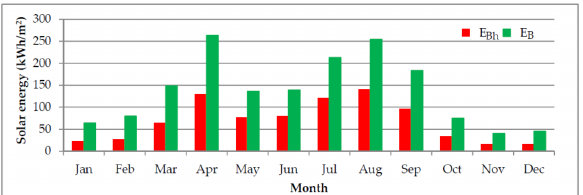
Figure 7. Monthly direct horizontal- and direct- solar energy calculated based on the on-site measured values in Brasov